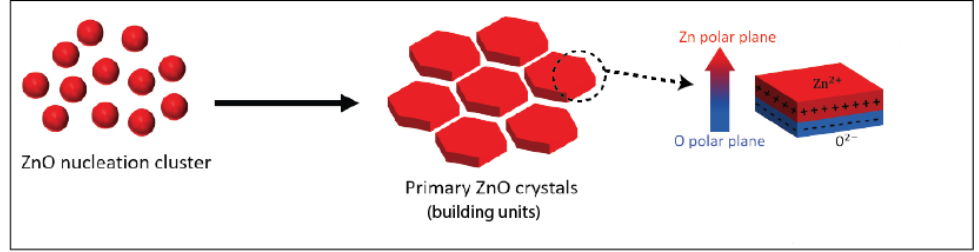
Figure 1. Nucleation and growth scheme of ZnO nanoparticle building